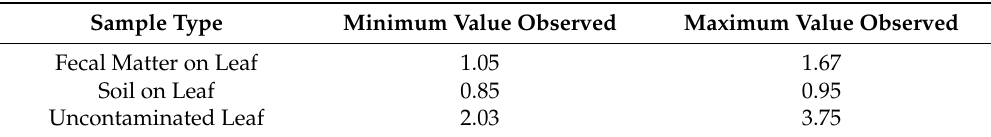
Figure 5. Typical spectral profiles recorded from 660 to 730 nm for fecal on leaf (• •), soil on leaf (——), and uncontaminated leaf samples ( ―― ). Table 3. Range of values for the ratio of 710:688 nm calculated for each sample type.